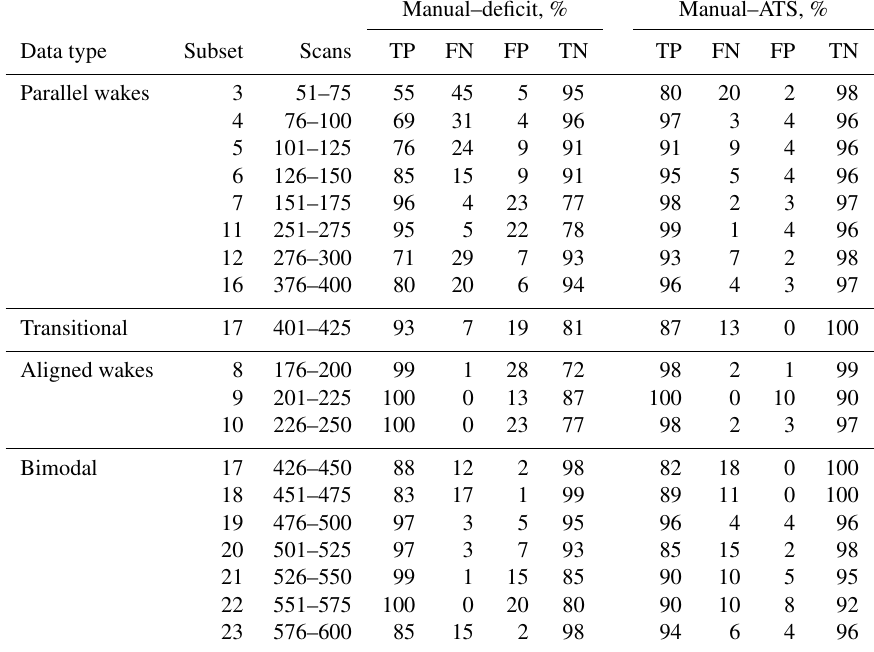
Table 3. Comparison of the thresholding methods’ performance against the manual wake